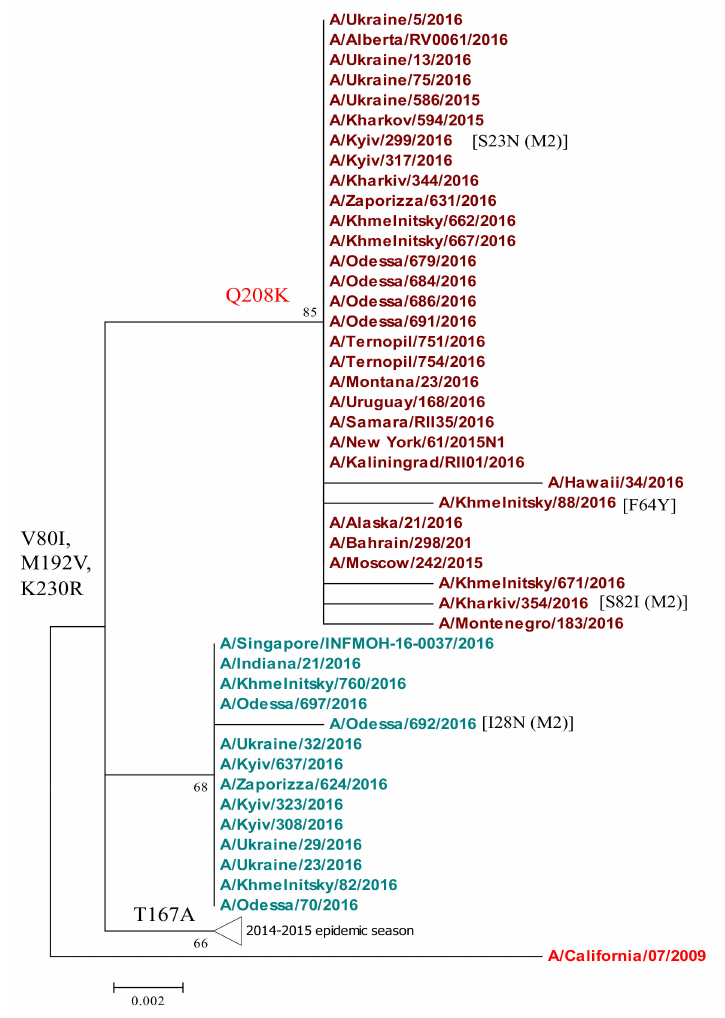
Figure 6. Phylogenetic analysis of A(H1N1)pdm09 influenza virus M1 from the 2015/16 season. M1 gene nucleotide sequences were analyzed by NJ method, Kimura 2-parameter model, with 1000 bootstrap replications. Ukrainian clades are colored except the vaccine strain which is red; amino acid variations are indicated as arising at specific branch nodes; M2 substitutions are also annotated